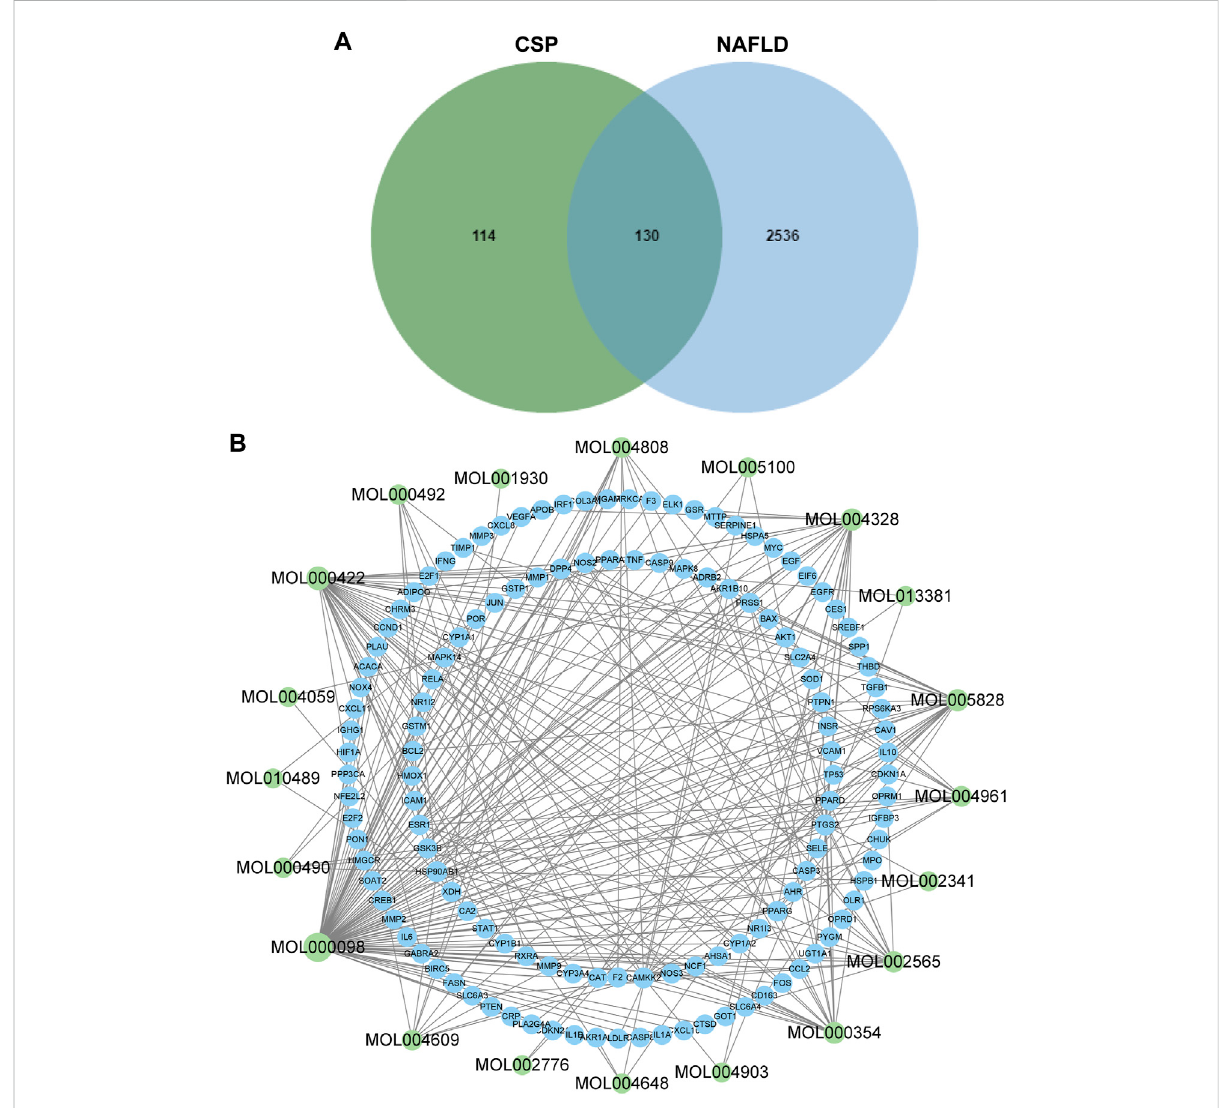
FIGURE 1 Components-Genes Network of CSP and NAFLD. (A) Overlaps between NAFLD genes and CSP-related genes; (B) The drug-bioactive ingredient target-disease network of CSP acting on NAFLD. Green nodes represent the compounds; blue nodes represent target